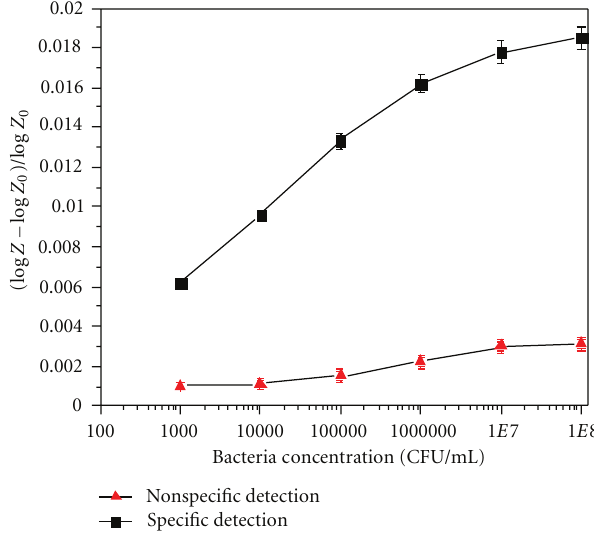
Figure 4: Calibration curve: the variation of the absolute value of / Log Z | (Log Z − Log Z | versus bacteria concentration (CFU/mL) 0 ) 0 at 233mHz. The specific detection was with E. coli and nonspecific detection with Enterococcus faecium bacteria